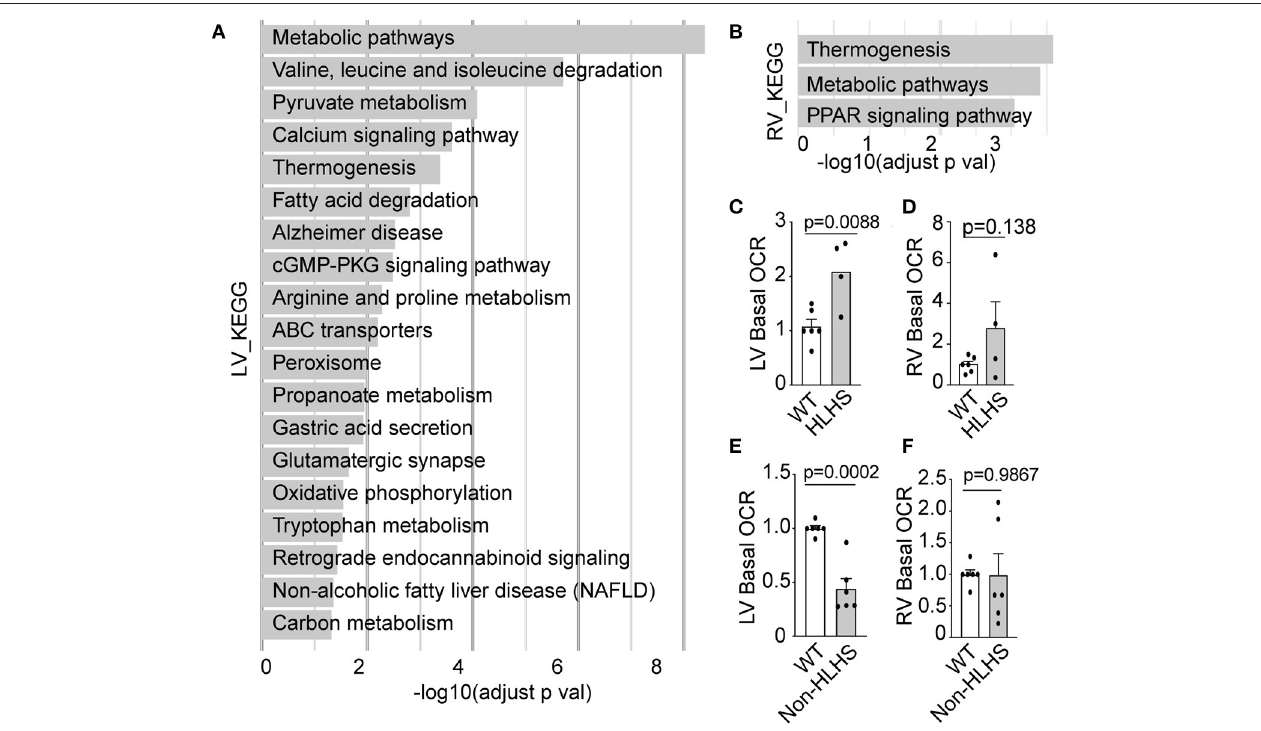
FIGURE 3 | Mitochondrial respiration in Ohia mutant mouse heart. (A,B) Pathways recovered among downregulated genes at FDR 0.05 from RNA-seq analysis of HLHS-LV (A) or RV (B) tissue compared to that of WT littermate control. Pathway enrichment analysis was performed using KEGG pathway analysis with g: Profiler and FDR < 0.05. (C–F) Basal OCR in LV and RV heart tissue from E14.5–16.5 Ohia line with Sap130/Pcdha9 mutations known to cause HLHS. This analysis was obtained using the Seahorse Analyzer. (C,D) Data obtained from litters comprising WT ( n = 7) and HLHS ( n = 4). (E,F) Quantitative analysis of five Sap130/Pcdha9 mutants with normal cardiac anatomy without HLHS (E,F) and six WT controls. Bar graphs show mean ± SEM with Student’s t -test. Each dot represents one mouse embryo heart tissue. FDR, false discovery rate; HLHS, hypoplastic left heart syndrome; KEGG, Kyoto Encyclopedia of Genes and Genomes; LV, left ventricle; OCR, oxygen consumption rate; PPAR, peroxisome proliferator-activated receptor; RNA-seq, RNA sequencing; RV, right ventricle; WT,